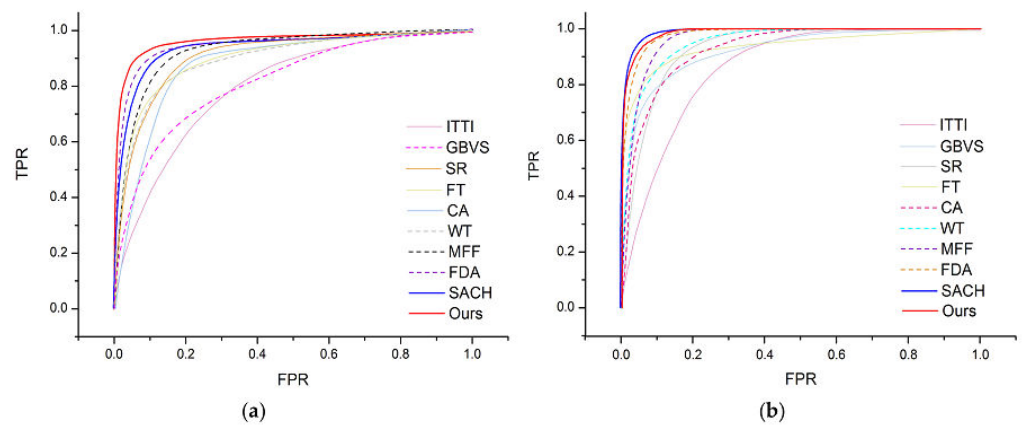
Figure 9. ROC curves of our proposed model and nine competing models on ( a ) SPOT 5 and ( b ) Google Earth images.